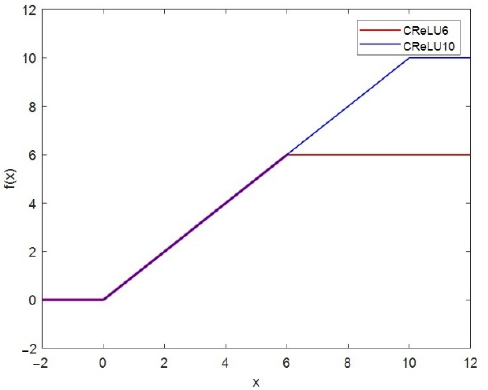
Figure 5. The waveform of CReLU activation function (where CReLU6 represents the ceiling factor c takes 6, and CReLU represents the ceiling factor c takes